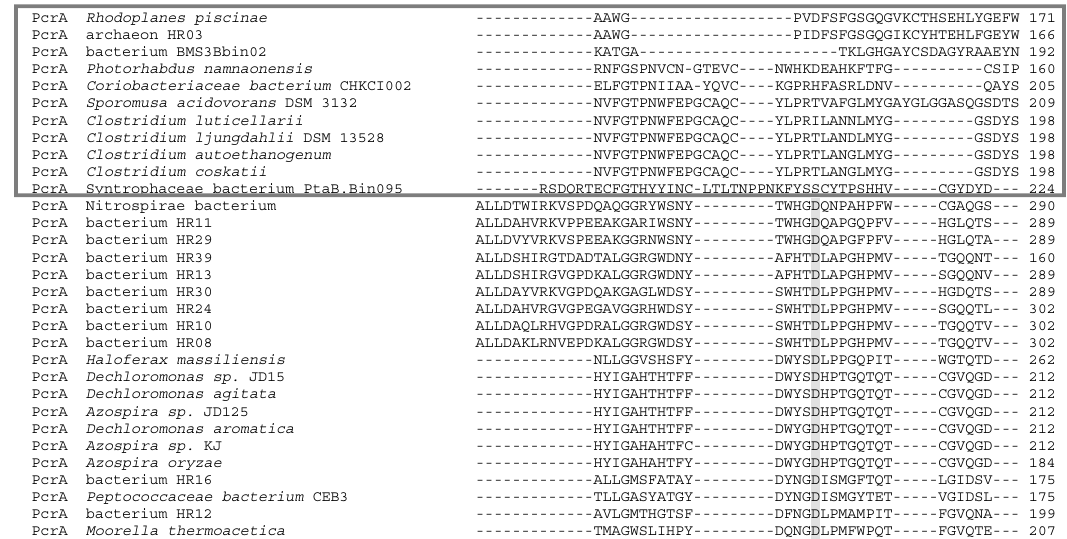
Figure 7. Clustal Omega alignment of all PcrA proteins. Aspartate, which coordinates Mo atom, is in grey. Grey box represents the separate clade of PcrA in which their aspartate is not aligned with the aspartate from the two other groups of